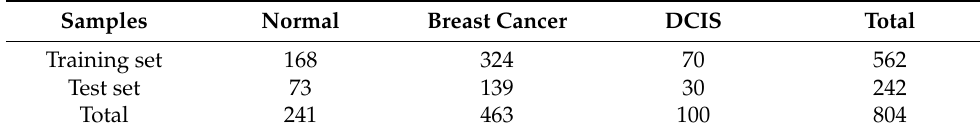
Table 2. Division of train set and test set.